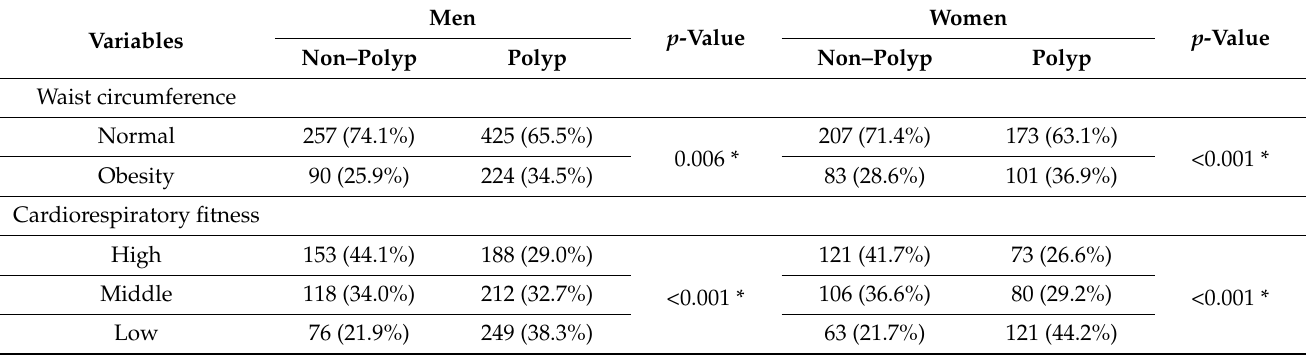
Table 2. Incidence of colorectal polyps associated with different